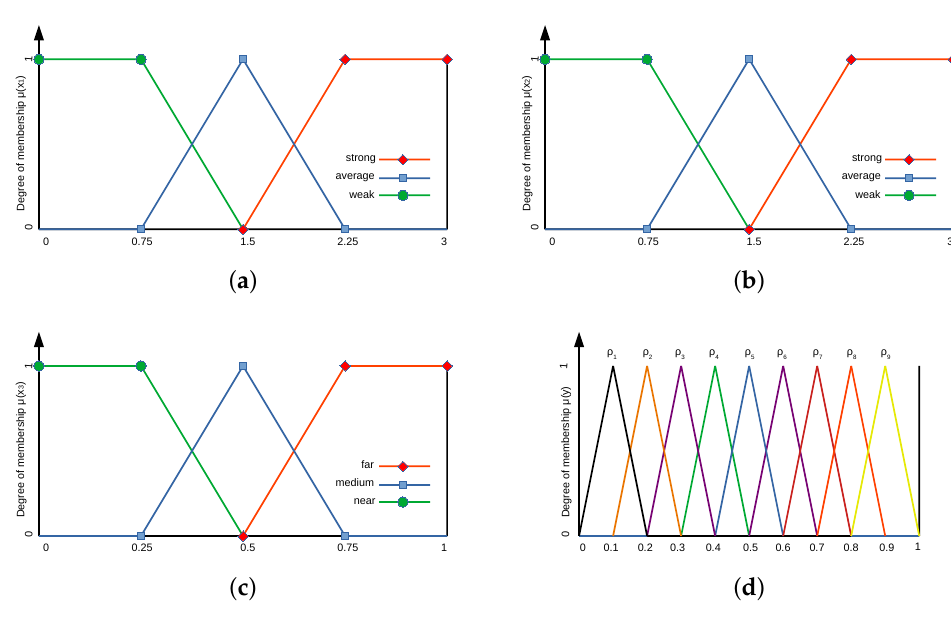
Figure 3. Membership functions. ( a ) h SR